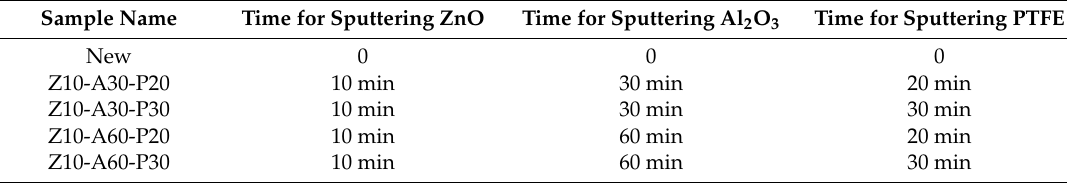
Table 1. Sample preparation parameters.